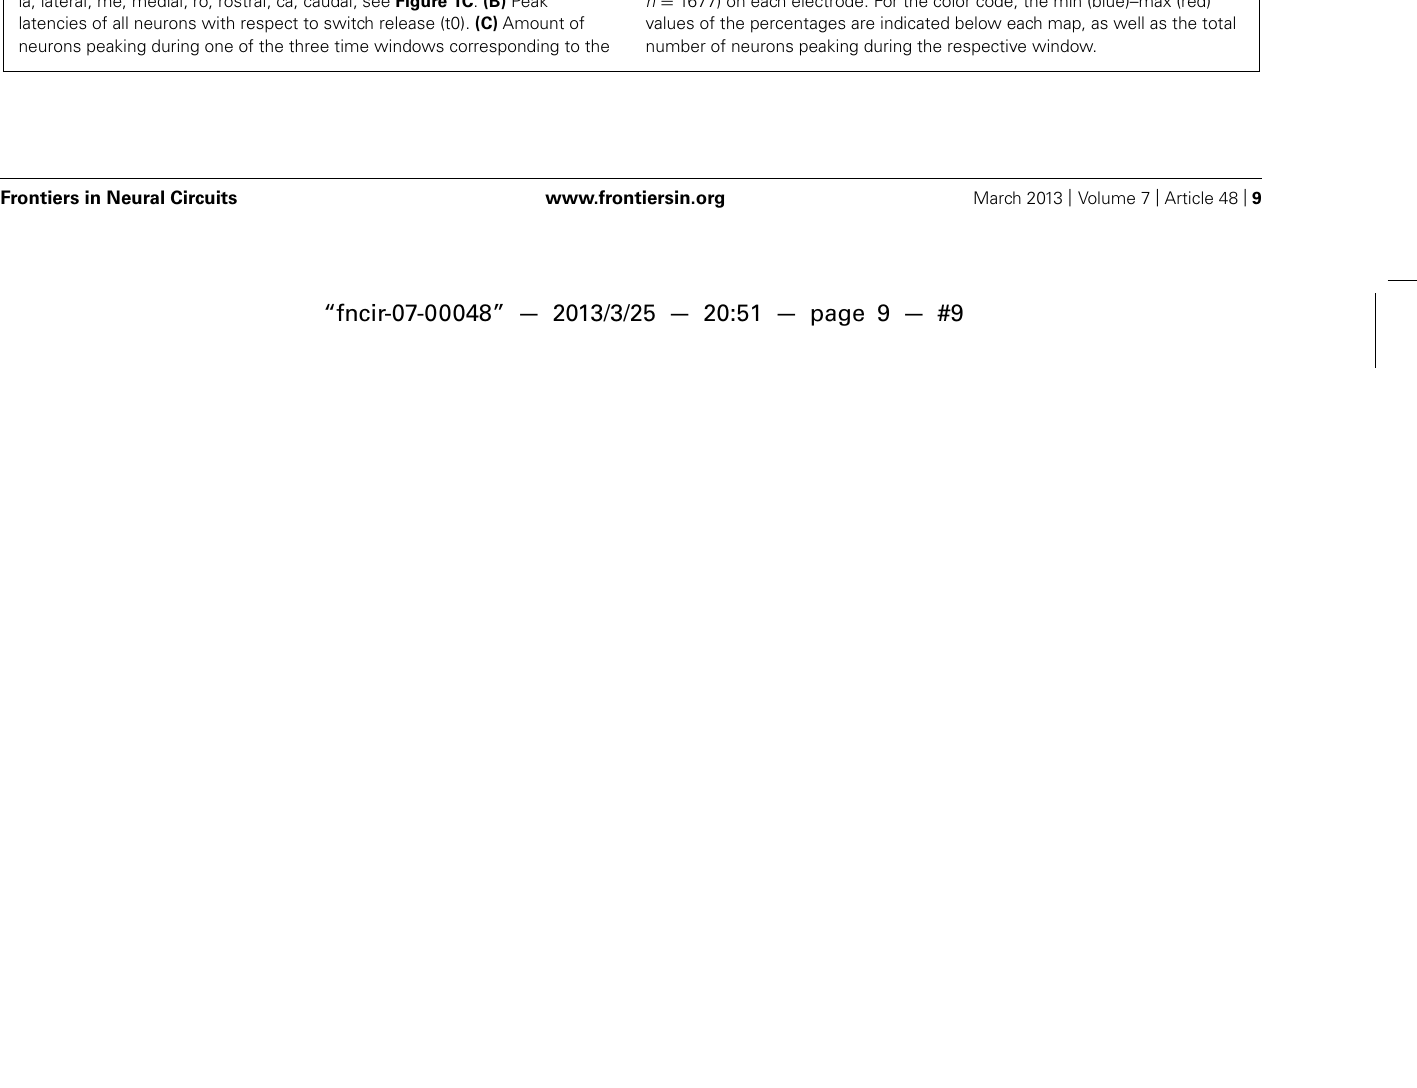
FIGURE 8 | (A) Total number of neurons recorded on each electrode during the 11 selected subsessions, peaking during ± 500 ms around switch release. la, lateral; me, medial; ro, rostral; ca, caudal; see Figure 1C . (B) Peak latencies of all neurons with respect to switch release (t0). (C) Amount of neurons peaking during one of the three time windows corresponding to the